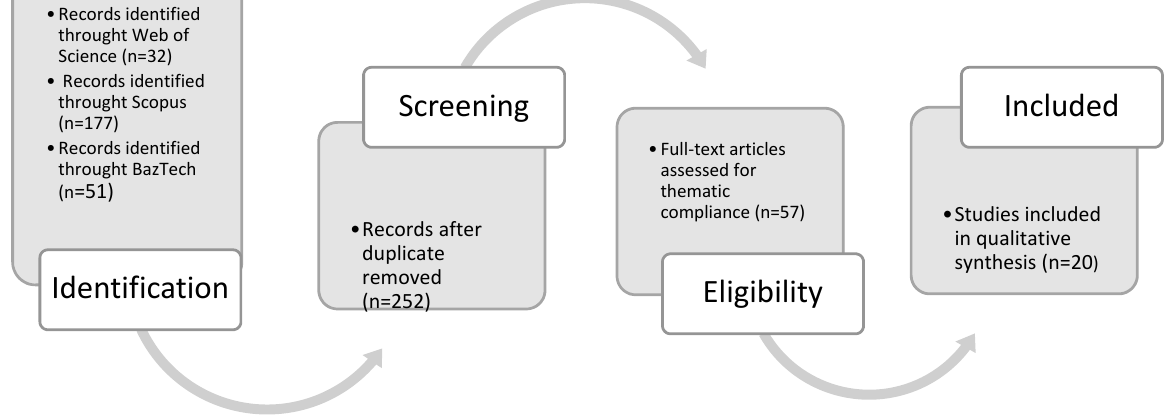
Figure 3. The method for selecting publications containing information on the procedure for deter- mining compensation for expropriated real estate implemented in Poland.